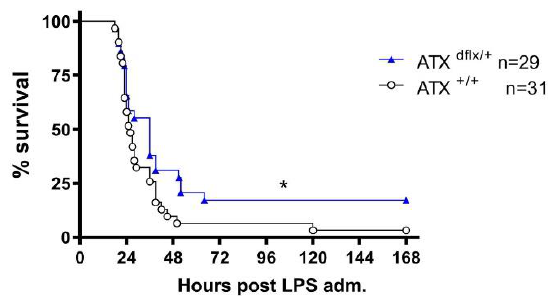
Figure 1. Increased survival rates in LPS-treated heterozygous transgenic ATX knockout mice. Kaplan–Meier survival curves of ATX df/+ mice and appropriate littermate controls. Presented results are cumulative from four independent experiments. Differences were tested with the Logrank test. * p < 0.05.